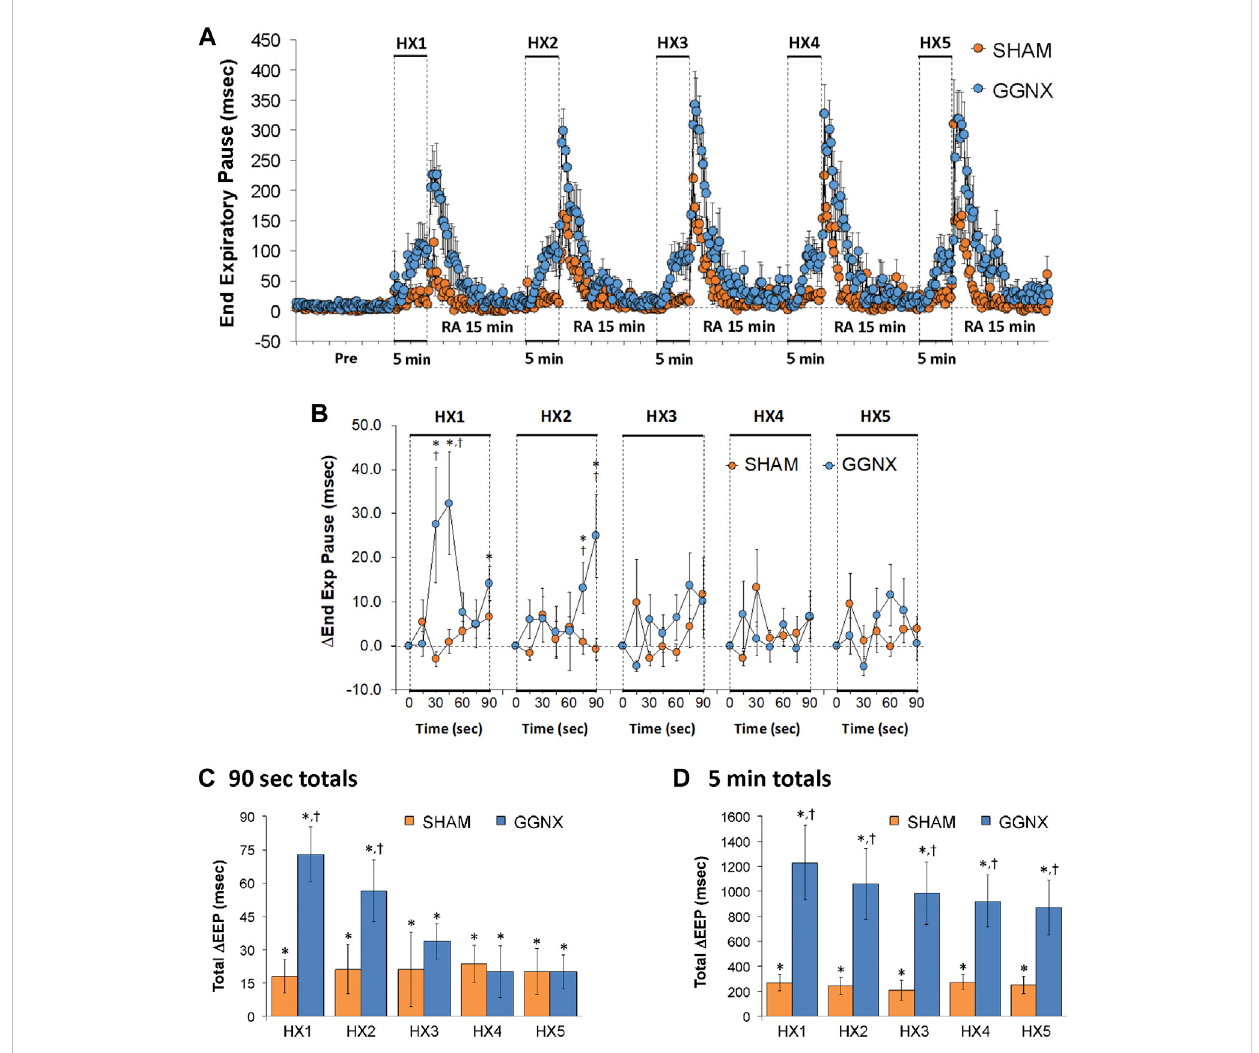
FIGURE 8 (A) End Expiratory Pause (EEP) values in sham-operated (SHAM) rats and in rats with bilateral ganglioglomerular nerve transection (GGNX) before (Pre) and during fi ve hypoxic (HX, 10% O 2 , 90% N 2 ) gas challenges, each separated by 15 min of room-air (RA). (B) Arithmetic changes in EEP during the fi rst90 sofHXgaschallenge. (C) TotalchangesinEEPduringthe fi rst90 sofHXgaschallenge. (D) TotalchangesinEEPduringtheentire5 minofHXgas challenge. The SHAM group had 10 rats. The GGNX group had 12 rats. The data are presented as mean ± SEM. * p < 0.05, signi fi cant response. † p < 0.05, GGNX rats versus SHAM